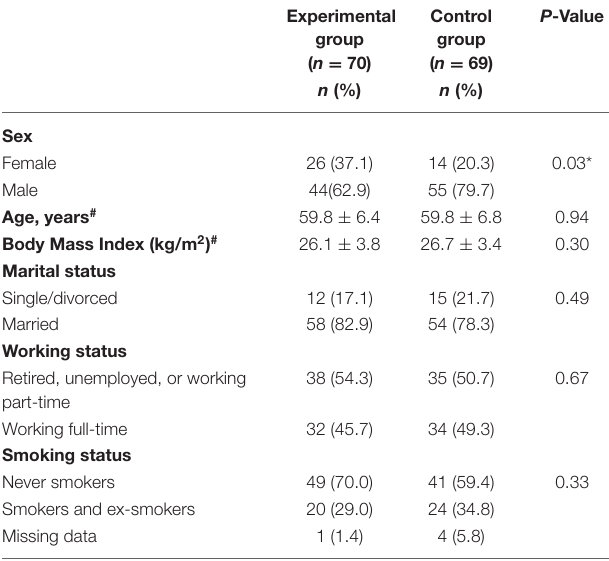
TABLE 1 | Characteristics of the participants at baseline ( n =